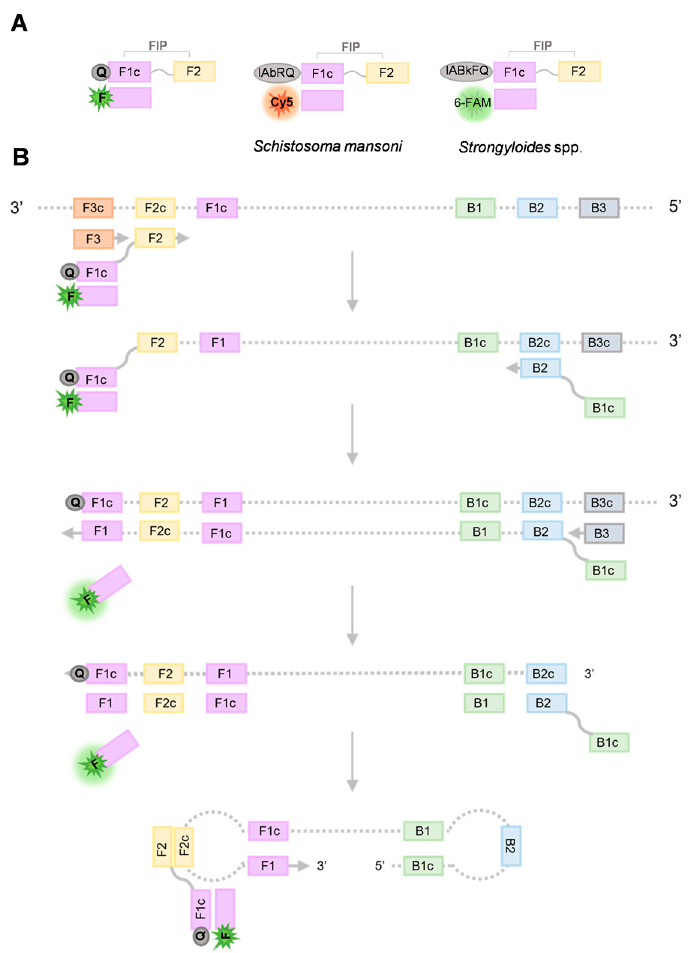
Figure 6. Schematic illustration of customized primers and the principle of the DARQ-LAMP technique. ( A ) Schematic illustration of a Quencher Probe Duplex (QPD), with a 5 ′ -quencher FIP (Q-F1c + F2 sequence) annealed to a sequence complementary to F1c labeled at the 3 ′ end with fluorophore (Fd). In this study, from each set of primers used, both FIP primers (comprising F1c + F2 sequences) were labelled at 5 ′ end by adding a dark quencher (Q-FIP): Iowa Black RQ (IAbRQ) for Schistosoma. mansoni -FIP primer and Iowa Black FQ (IAbFQ) for Strongyloides spp.-FIP primer. F1c sequences complementary probes were designed and labelled with a fluorophore at 3 ′ end: Cyanine 5 (Cy5) and 6-Carboxyfluorescein (6-FAM) for amplification of S. mansoni and Strongyloides spp., respectively. ( B ) Schematic diagram of DARQ-LAMP operation, with LAMP inner primers FIP (F1c + F2) and BIP (B1c + B2) and outer primers F3 and B3 and the QPD (Q-FIP + Fd). (1) LAMP is initiated at the F2c sequence of the DNA target, with the Fd probe turned off by hybridization to Q-FIP. This new strand is displaced by upstream synthesis from the external primer F3. (2) The BIP primer (B1c + B2) is anchored to the B2c sequence on the newly synthesized strand. (3) Synthesis from the primer B3. (4) The resulting structure undergoes exponential amplification in the LAMP reaction. Succes- the signal.